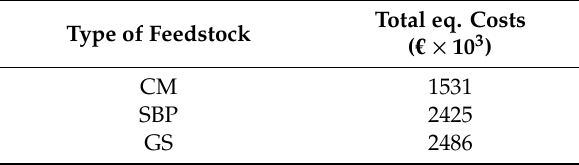
Table 10. Equipment costs of a biogas power plant.